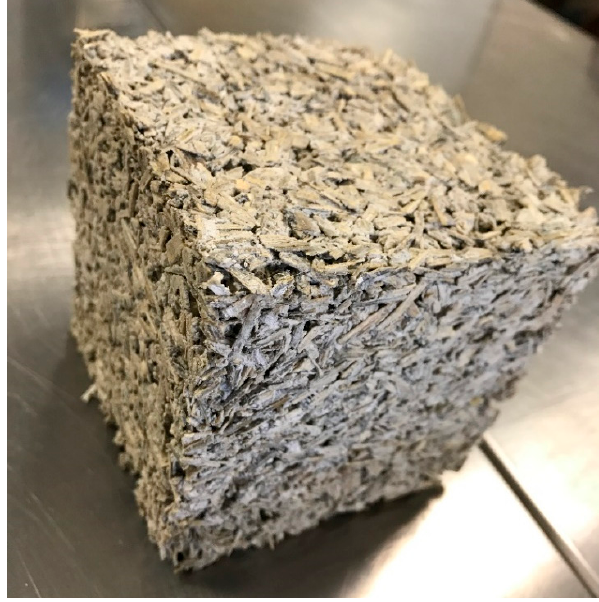
Figure 1. Hemp–lime composite mixture 1.